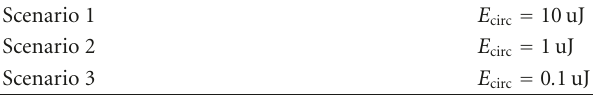
Table 3: Examined